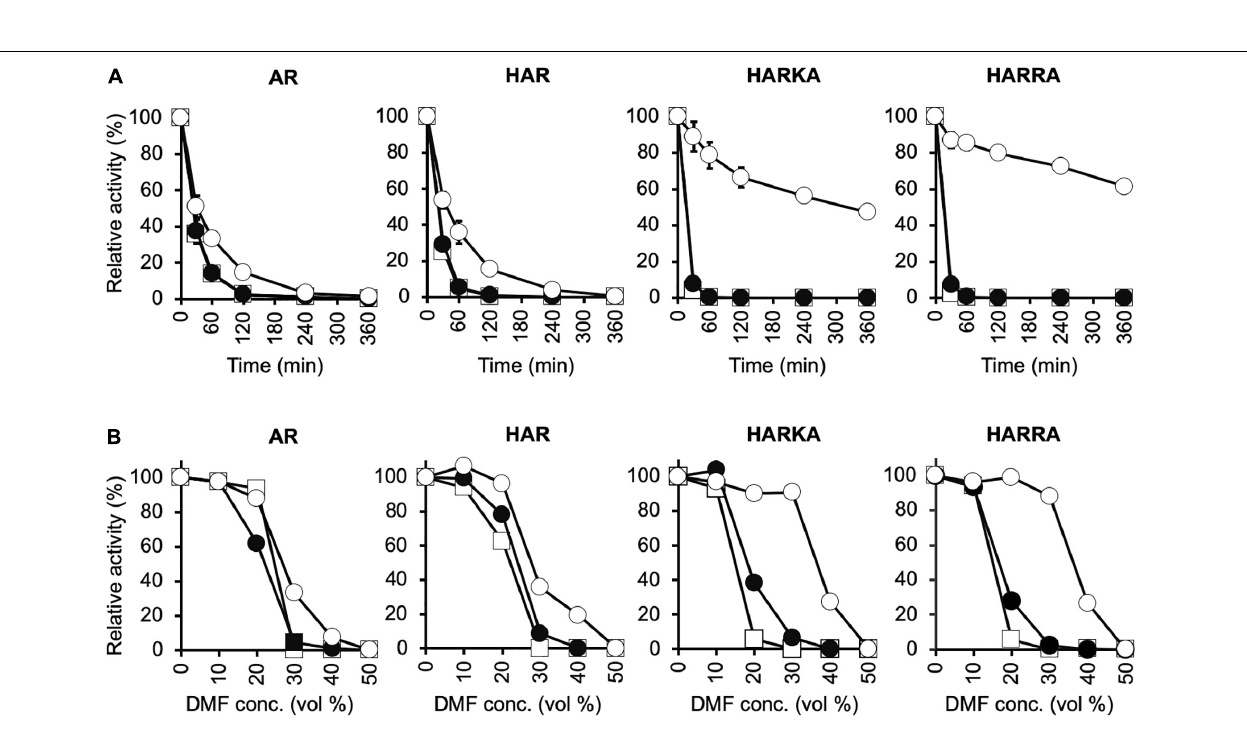
FIGURE 3 | Characterization of the thermal stability and tolerance to organic solvents for RsPtxD variants. (A) Thermal inactivation of RsPtxD mutants at 45 ◦ C. Data are presented as the mean ± standard deviation from three experiments. (B) Stabilities of RsPtxD mutants in DMF. Prior to the assay reaction, RsPtxD mutants were incubated in the 50 mM MOPS (pH7.3) containing 0.5 mM NAD (filled circles), 0.5 mM NADP (open circles), or without cofactor (squares). The reactions were performed by using 0.5 mM NADP as a nicotinamide substrate. The data are representative of two independent experiments. AR, RsPtxD AR ; HAR, RsPtxD HAR